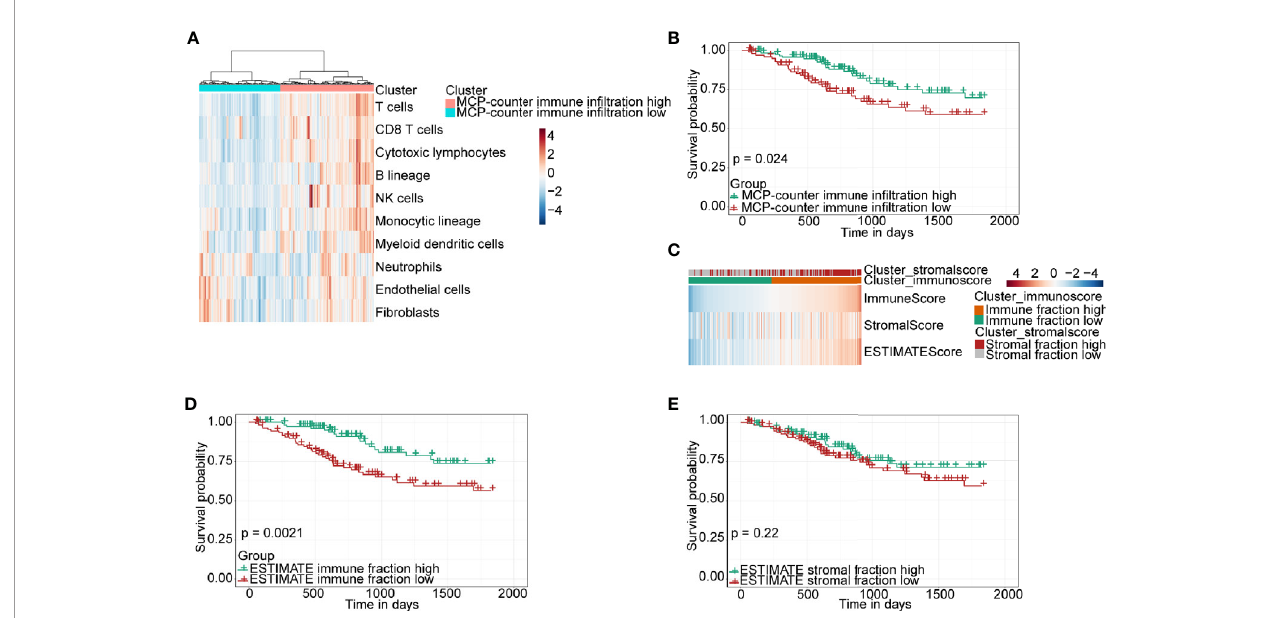
FIGURE 1 | Immune classi fi cation and survival analysis of 250 CSCC patients selected from TCGA database. (A) Heatmap of TME composition as de fi ned by the MCP-counter algorithm. (B) Kaplan – Meier survival curve for immune in fi ltration-high and in fi ltration-low groups determined by the MCP-counter. (C) Heatmap showing immune and stromal fraction by the ESTIMATE algorithm. (D, E) Kaplan – Meier survival curve for patients with high and low fractions of immune cells and stromal cells classi fi ed by the ESTIMATE